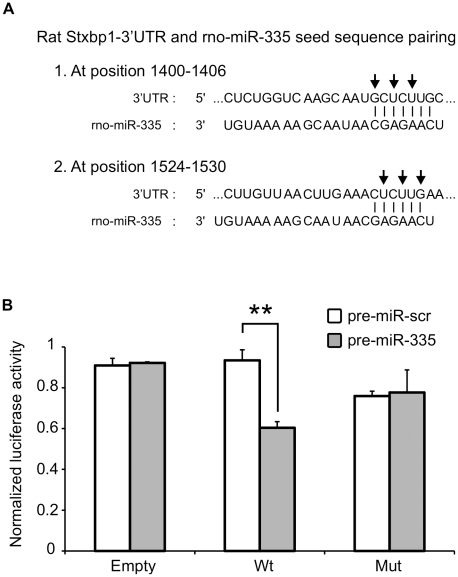
Interaction of rno-miR-335 with the predicted binding sites in the 3′UTR of rat Stxbp1.
A. The rat Stxbp1 3′UTR contains two putative miR-335 binding sites as predicted by TargetScan 5.1. The two sites are located in the proximal region and both could be included in a 200 bp fragment cloned into a dual luciferase reporter plasmid. Arrows indicate the sites in the seed sequences that were mutated into complementary bases to act as negative control in the luciferase assay B. Two inserts, one with the wildtype rat Stxbp1-3′UTR sequence (Wt) and the other with sequences mutated at both miR-335 predicted binding sites (Mut) were cloned into the pmiRGLO dual luciferase vector. The pmiRGLO dual luciferase vector alone (Empty) was included as positive controls. HeLa cells were co-transfected with the empty vector or plasmid constructs and pre-miR-335 or pre-miR-scr (control with scrambled sequence) and assayed after 48 hours. Transfection efficiency was normalized using the Renilla signal. Data represents two independent transfections ± S.E.M. with n = 3. (**) P<0.01.